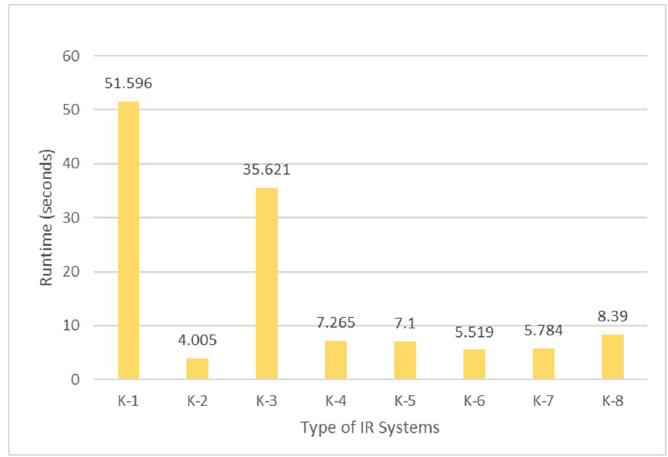
Fig. 10 Average runtime graph for news dataset IV. D